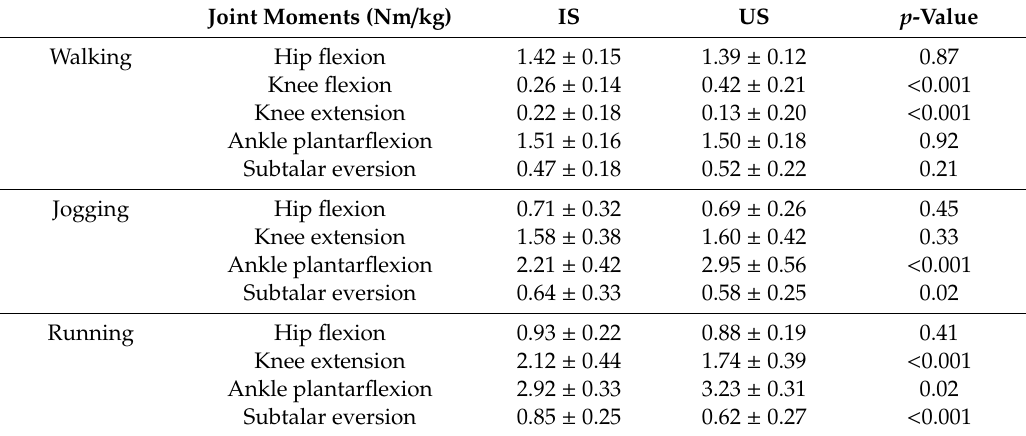
Table 3. The peak joint moments of the involved side (IS) and the uninvolved side (US) during walking, jogging and running